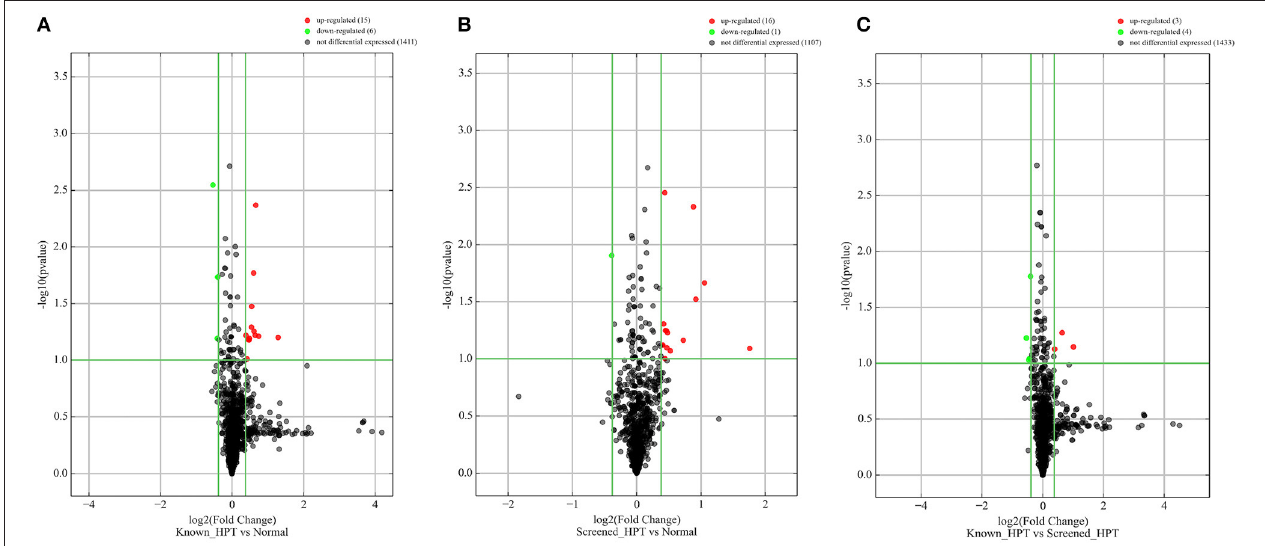
FIGURE 2 | Differentially expressed pre-miRNAs in comparison between blood pressure groups. (A) Is a comparison between known hypertensives and normotensives. (B) Is a comparison between screen-detected HPT and normotensives. (C) Is a comparison between known HPT and screen-detected HPT. Significantly different expression of a pre-miRNA was those in which there was a ≥ 1.3-fold change difference in expression between comparison groups and p ≤ 0.1. Red and green dots signify upregulated and downregulated miRNAs, respectively. No differential expression was signified with a black